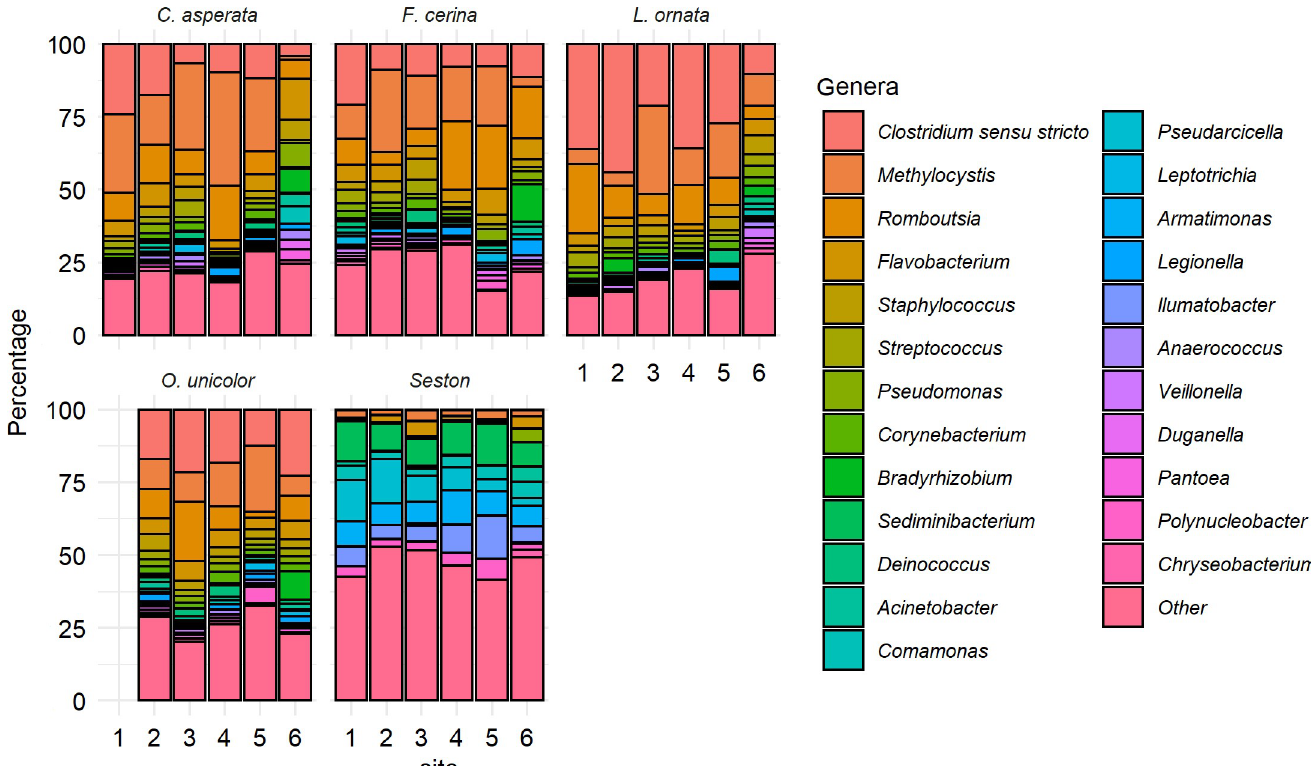
Fig 3. Major bacterial genera in the gut microbiome of four freshwater mussel species (in order shown: Cyclonaias asperata , Fusconaia cerina , Lampsilis ornata , and Obovaria unicolor ) at six sites in the Sipsey River, AL, USA, and for suspended seston collected from the same sites, as determined by Illumina 16S rRNA gene sequencing. Stacked bar plots are arranged with the most abundant genus overall ( Clostridium sensu stricto ) at the top. No O . unicolor samples were found at site 1. The 24 most abundant genera are shown and represent 73% of all sequencing reads that were identified to the genus level. Sequences classified at the genus level made up 35.7% of the total data. All other bacterial genera are grouped together as “other”.